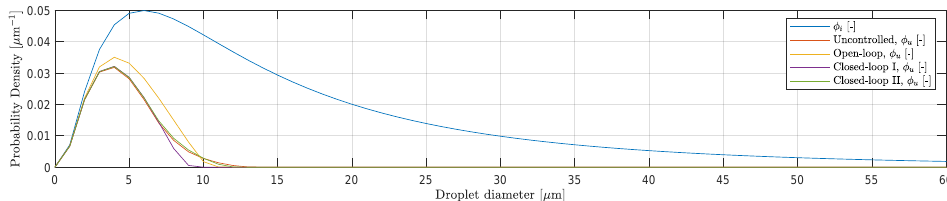
Figure 13. Average oil droplet distributions of the four scenarios.